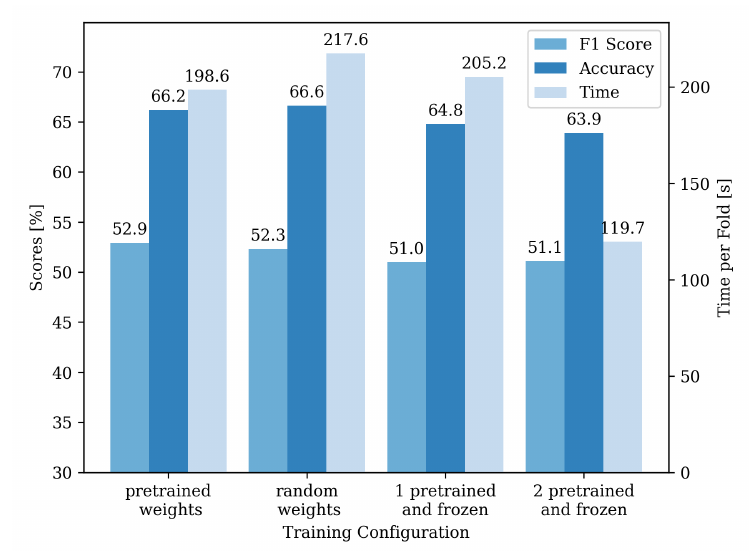
Figure 7. Comparison of the accuracy, F1 score, and training time for different transfer learning configurations. The scale for the accuracy and F1 score is shown on the left y-axis, and for the training time on the right y-axis. In the configuration of the pre-trained weight, all three convolutional layers were initialized with the weights of the network trained on volleyball data but not frozen. For the random weights configuration, all layers were randomly initialized. For the configurations with one or two frozen layers, the model is initialized with pre-trained weights, and the weights are frozen in the later training procedure.